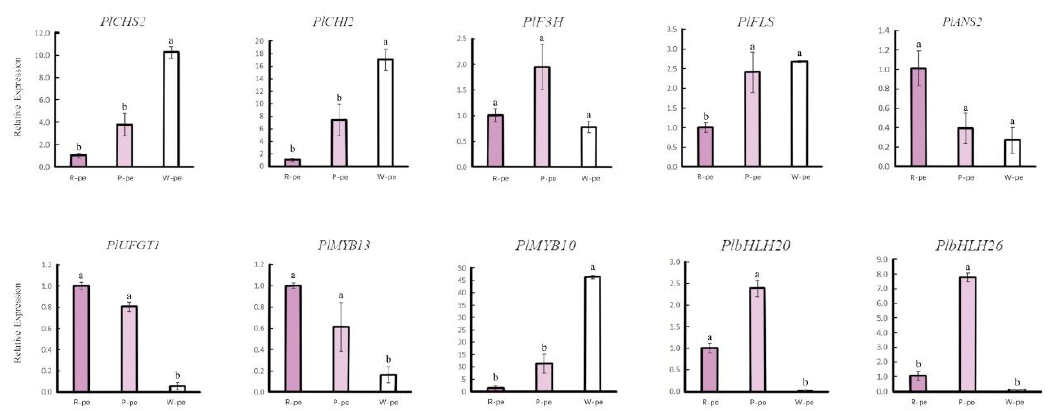
Figure 6. Real time quantitative reverse transcription-PCR of several genes in P. limprichtii . Each value is shown as average ± standard deviation from three biological replicate sampling.